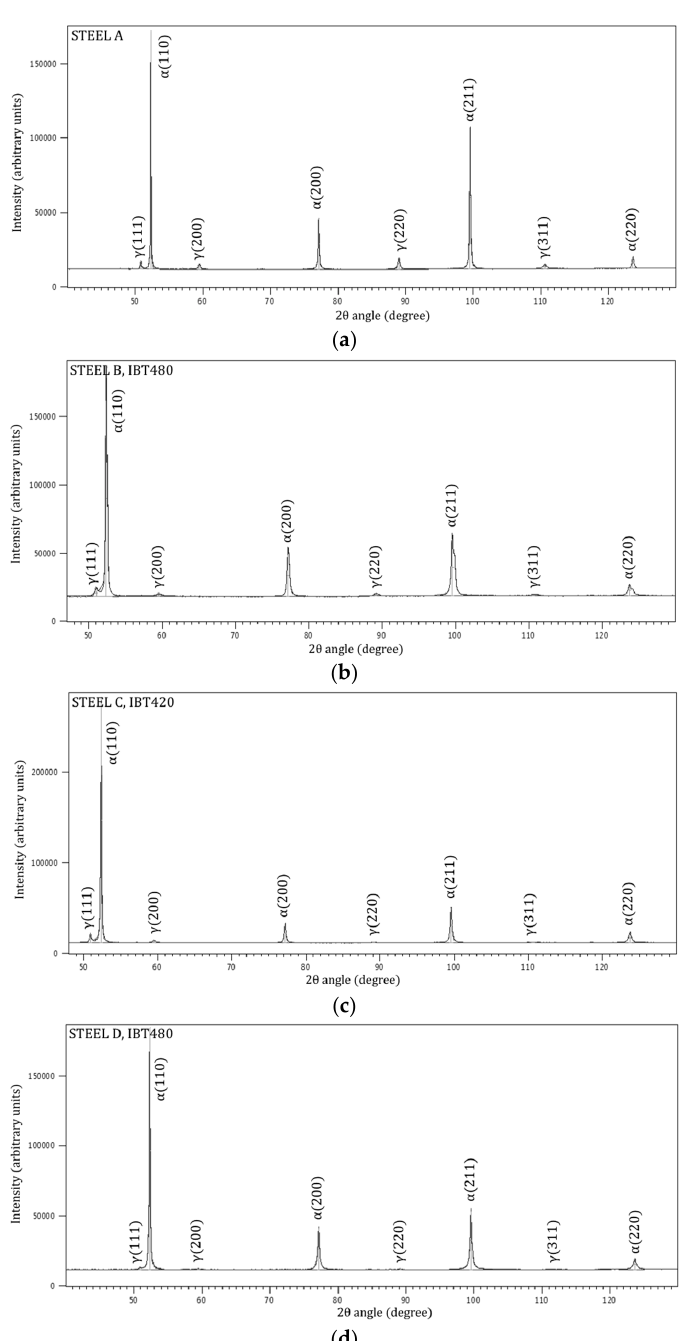
Figure 4. The observed XRD spectra for ( a ) Steel A, ( b ) Steel B IBT480, ( c ) Steel C IBT420, and ( d ) Steel D IBT480.